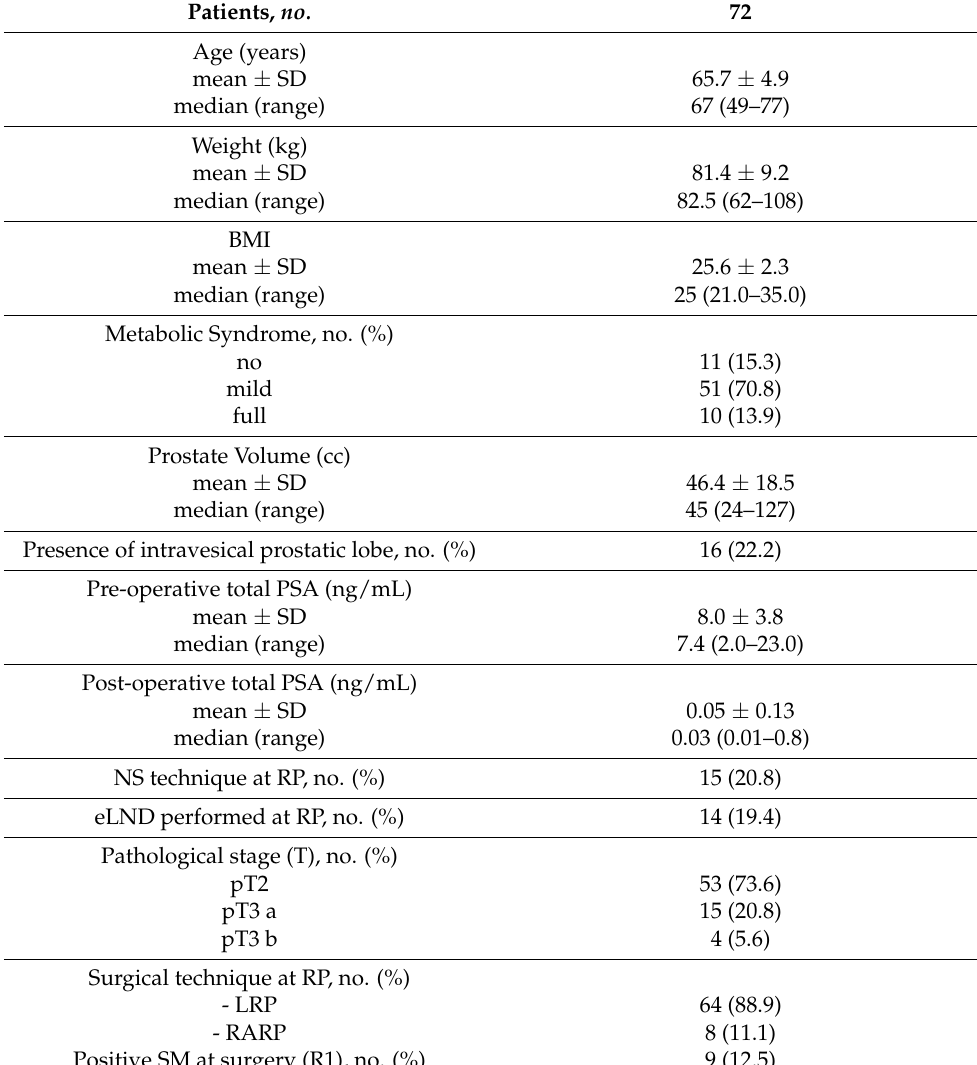
Table 1. Characteristics of the population submitted to pelvic floor rehabilitation for urinary inconti- nence after radical prostatectomy. Patients,